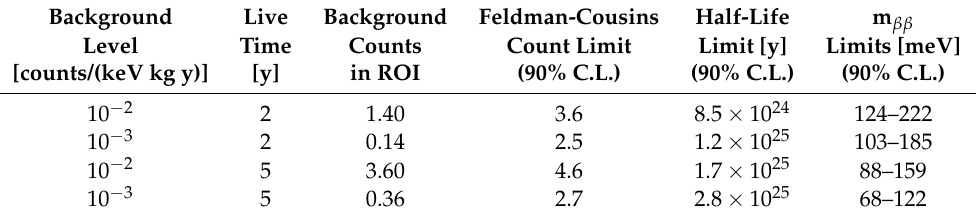
Table 5. Sensitivity of the CROSS demonstrator to be operated in the cryogenic facility of the Canfranc underground laboratory, under two different hypotheses of background level. The efficiency is 75%, compatible with the crystal size of each element. The interval of limits on the effective Majorana neutrino mass m ββ accounts for a recent compilation of nuclear-matrix-element calculations [24]. Background Live Background Feldman-Cousins Half-Life m ββ Level Time Count Limit Limit [y] in